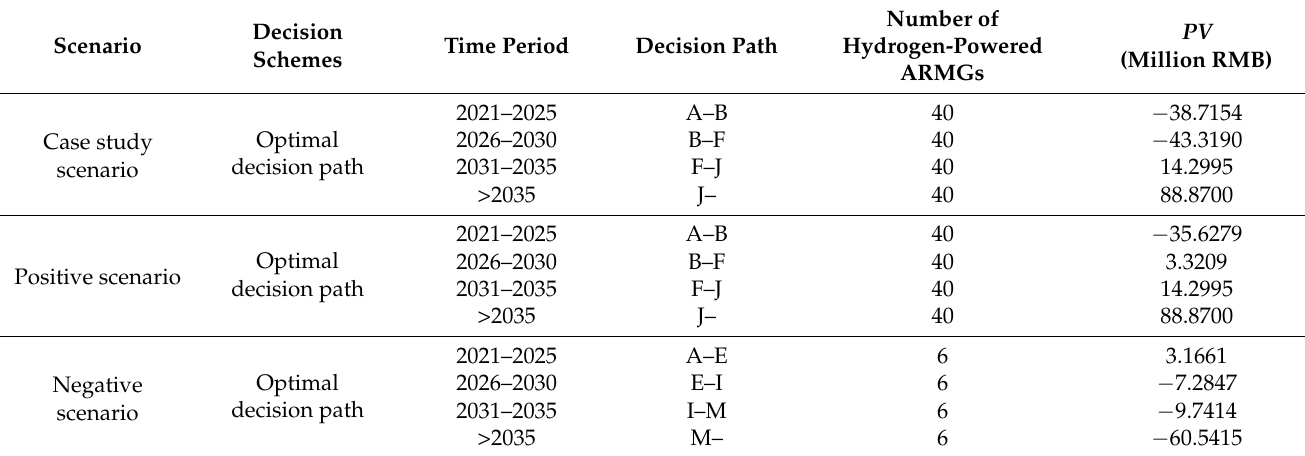
Table 6. Investment decision result of Qingdao Port ARMGs’ low-carbon transition under the change in hydrogen